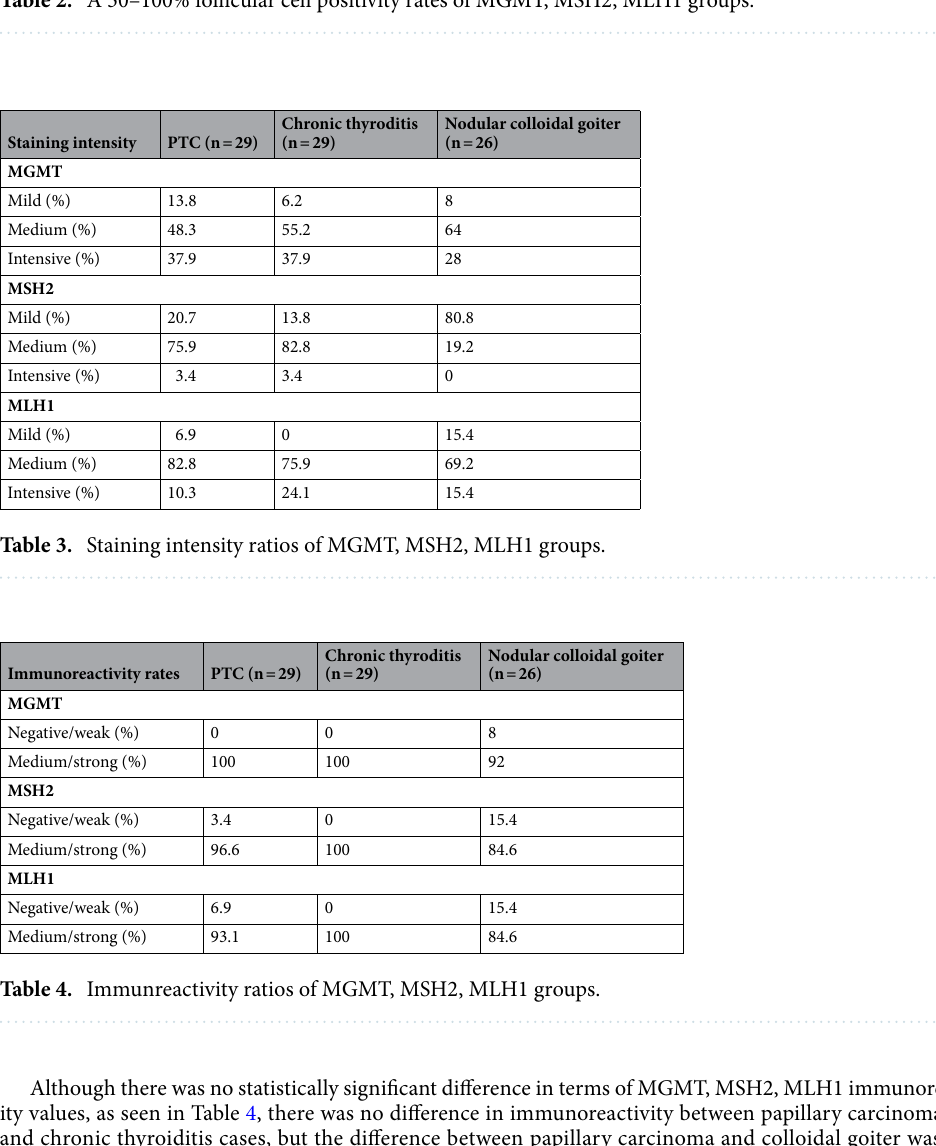
Table 2. A 50–100% follicular cell positivity rates of MGMT, MSH2, MLH1 groups.